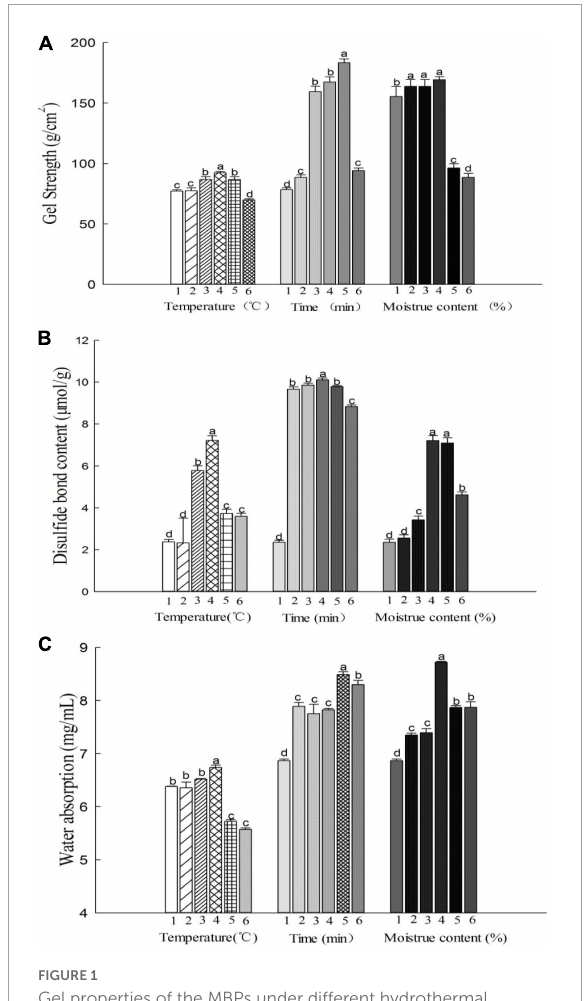
FIGURE1 Gel properties of the MBPs under different hydrothermal treatment conditions. Numbers 1–6 for the temperature represent the MBP groups treated with different hydrothermal temperatures (25, 65, 75, 85, 95, and 105 ◦ C, respectively). Numbers 1–6 for the time represent the MBP groups treated with different hydrothermal times (0, 15, 30, 45, 60, and 75 min, respectively). Numbers 1–6 corresponding to the moisture content represent the MBP groups treated with different moisture contents (0, 15, 20, 25, 30, and 35%, respectively). The letters a–d represent significant differences between the groups. (A) Gel strength. (B) Disulfide bond content. (C) Water